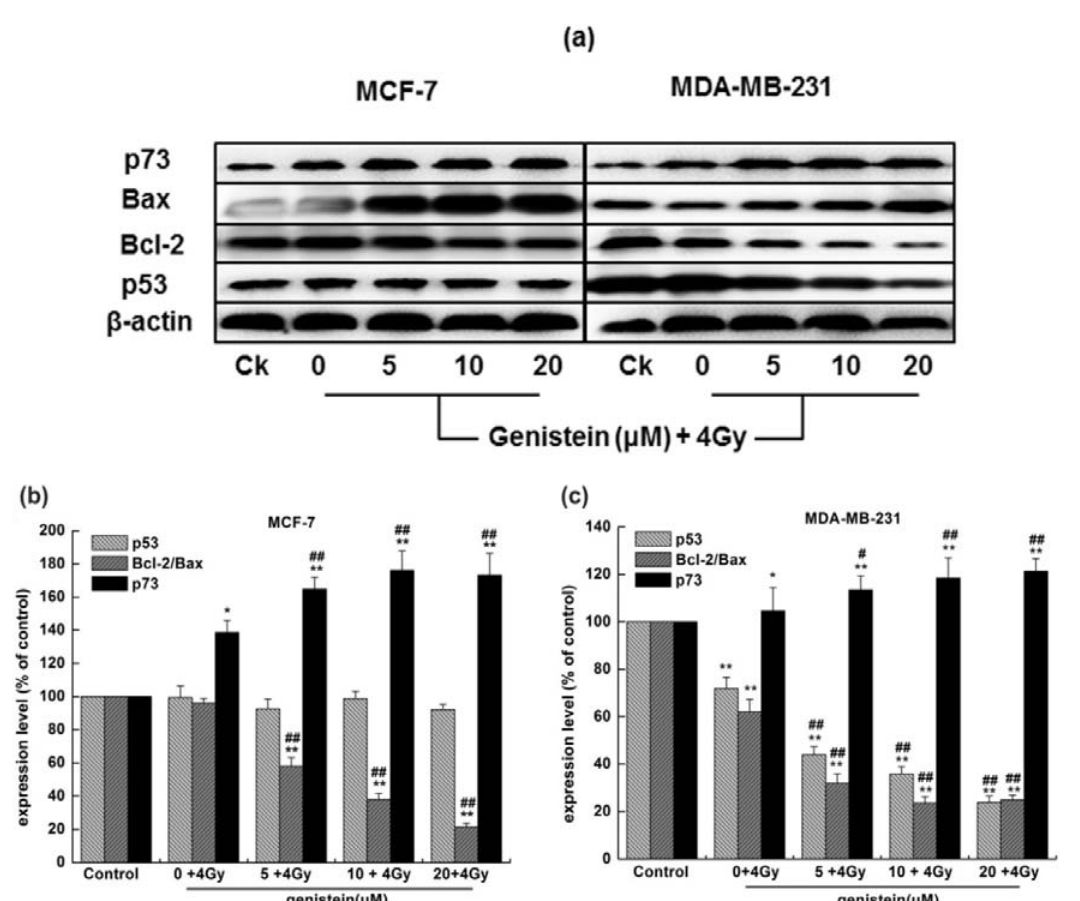
Figure 9. Effect of genistein combined with X-ray irradiation on the expression of cell apoptosis-related proteins in MCF-7 and MDA-MB-231 cells. (a) Representative blots from three independent experiments, where β -actin served as a loading control; (b) Quantative protein expression levels relative to control in MCF-7 cells; (c) Quantative protein expression levels relative to control in MDA-MB-231 cells. All data are presented as means ± SD from three independent experiments. * p < 0.05, ** p < 0.01 versus control group; # p < 0.05, ## p < 0.01 versus X-rays